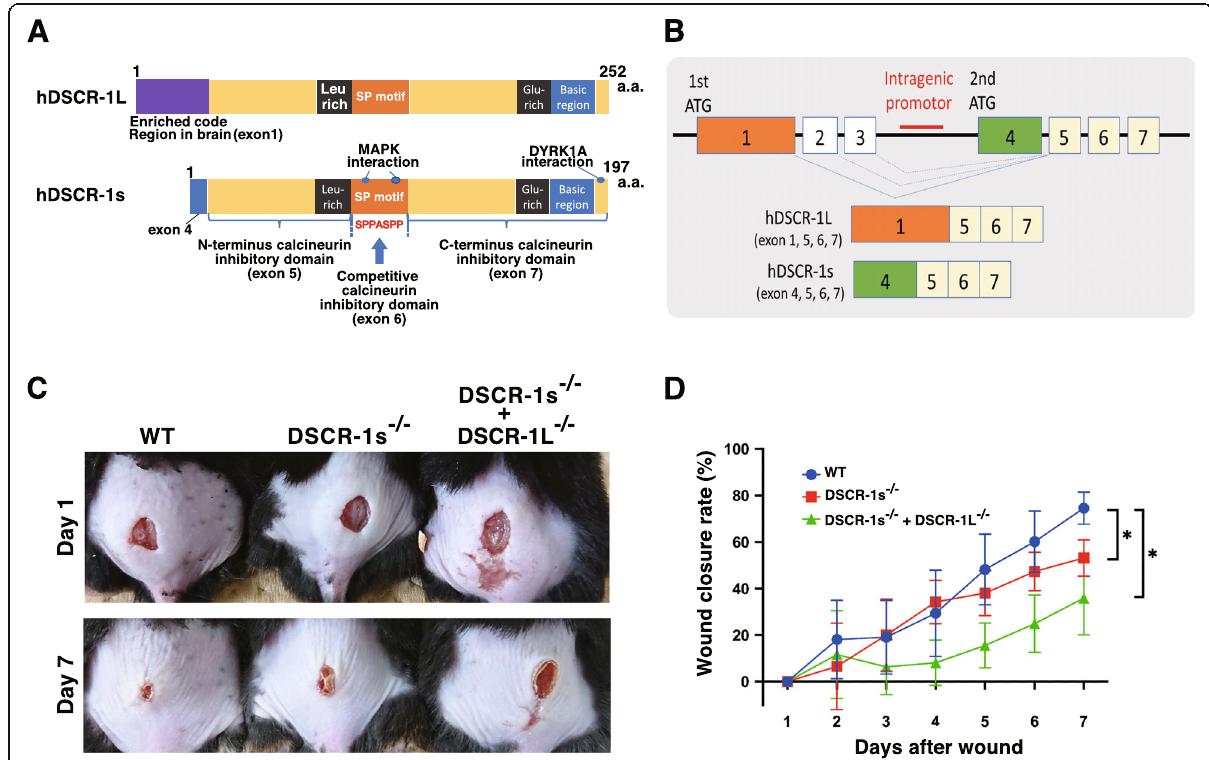
Fig. 2 DSCR-1-mediated wound healing. A Human DSCR-1L and DSCR-1s protein. a.a. amino acids. B Splicing patterns of human DSCR-1 genome. The schematic data is modified from ref. [35]. C The representative wound healing patterns after days 1 and 7. D Quantified wound closure rate. Data was shown as the mean and standard deviations, N = 3. * P < 0.05 compared with WT. WT wild-type control, Dscr-1s − / − mouse Dscr-1 short isoform-specific null mutation, Dscr-1L − / − mouse Dscr-1 long isoform-specific null